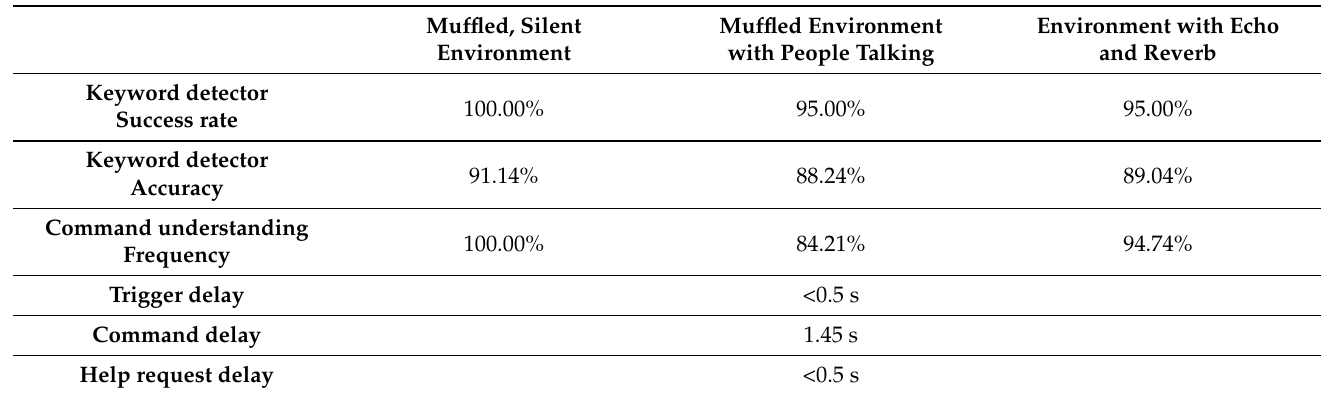
Table 3. Performances of vocal assistant PIC4Speech during the experimental